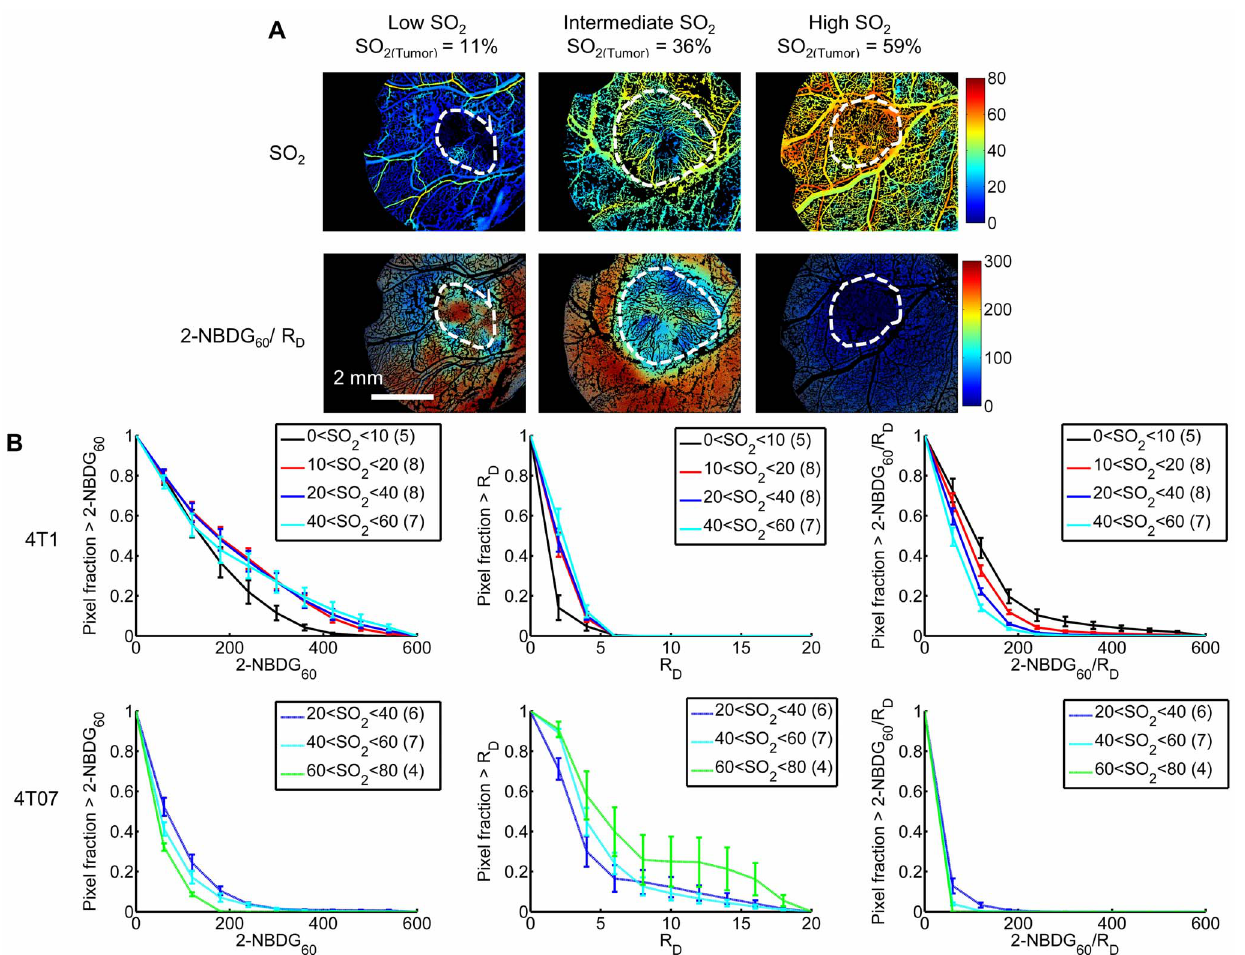
Fig. 6. The ratio 2-NBDG/R D facilitates assessment of glucose demand in heterogeneous regions of metastatic mammary tumors. (A) Representative images of vascular oxygenation (SO 2 ) and delivery-corrected 2-NBDG (2-NBDG 60 /R D ) for a 4T1 tumor with low mean SO 2 , a 4T1 tumor with intermediate mean SO 2 , and a 4T07 with high mean SO 2 . Adapted from Rajaram, et al. 2013. (B) Survival curves (1-cumulative distributions) show 2- NBDG 60 , R D , and 2-NBDG 60 /R D for regions of distinct SO 2 (%) in 4T07 and 4T1 tumors. For 4T1, 2-NBDG 60 is lower for 0 , SO 2,4T1 , 10 regions than for any other SO 2,4T1 (p 5 N.S.). Significantly lower rates of R D are seen for the 0 , SO 2,4T1 , 10 group than for well-oxygenated 4T1 regions (p , 0.05 or p , 0.01 for 0 , SO 2,4T1 , 10 vs. 20 , SO 2,4T1 , 40 or 40 , SO 2,4T1 , 60, respectively). After correction for low R D , 2-NBDG 60 /R D increased slightly but significantly in hypoxic regions (p , 0.01 for 0 , SO 2,4T1 , 10 vs. 40 , SO 2,4T1 , 60). For 4T07, 2-NBDG uptake for the highest SO 2,4T07 regions decreased compared to the lowest SO 2,4T07 (p , 0.01 for all 20 , SO 2,4T07 , 40 vs. 60 , SO 2,4T1 , 80). R D is indistinguishable between SO 2,4T07 levels. After correction by R D , 2-NBDG 60 / R D is lowest for 60 , SO 2,4T07 , 80 (p , 0.01). Comparison between 4T1 and 4T07 shows that 2-NBDG 60 is higher for all SO 2,4T1 than all SO 2,4T07 (p , 0.01). On the other hand, R D for the best oxygenated 4T07 groups (40 , SO 2,4T07 , 60 and 60 , SO 2,4T07 , 80) is greater than for all 4T1 groups (p , 0.01 for all groups except 40 , SO 2,4T1 , 60 vs. 60 , SO 2,4T07 , 80 where p , 0.06). After correction by R D , 2-NBDG 60 /R D is higher for all SO 2,4T1 than all SO 2,4T07 (p , 0.01 for all SO 2,4T1 compared to all SO 2,4T07 ). Number of mice per group indicated by group name in